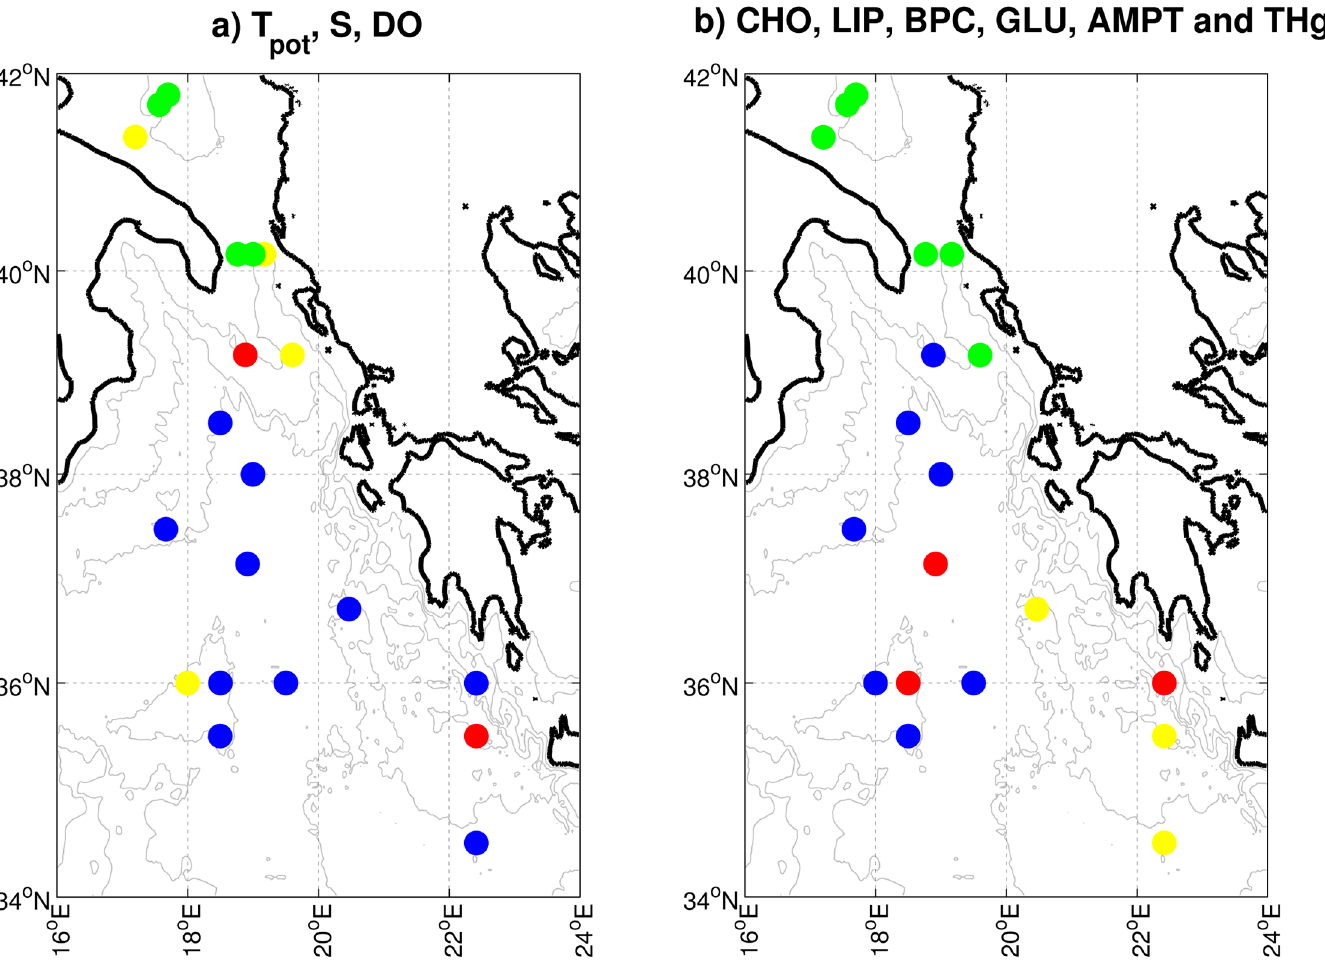
Fig 4. Grouping of the Eastern Mediterranean Sea bottom waters according to geophysical and biogeochemical parameters. Data are standardized Potential Temperature, S and DO data ( a ) and standardized CHO, LIP, BPC, GLU, AMPT and THg data ( b ). The grouping is based on a K-means clustering algorithm with four clusters. In each panel, the different colours identify the stations that belong to the same group.